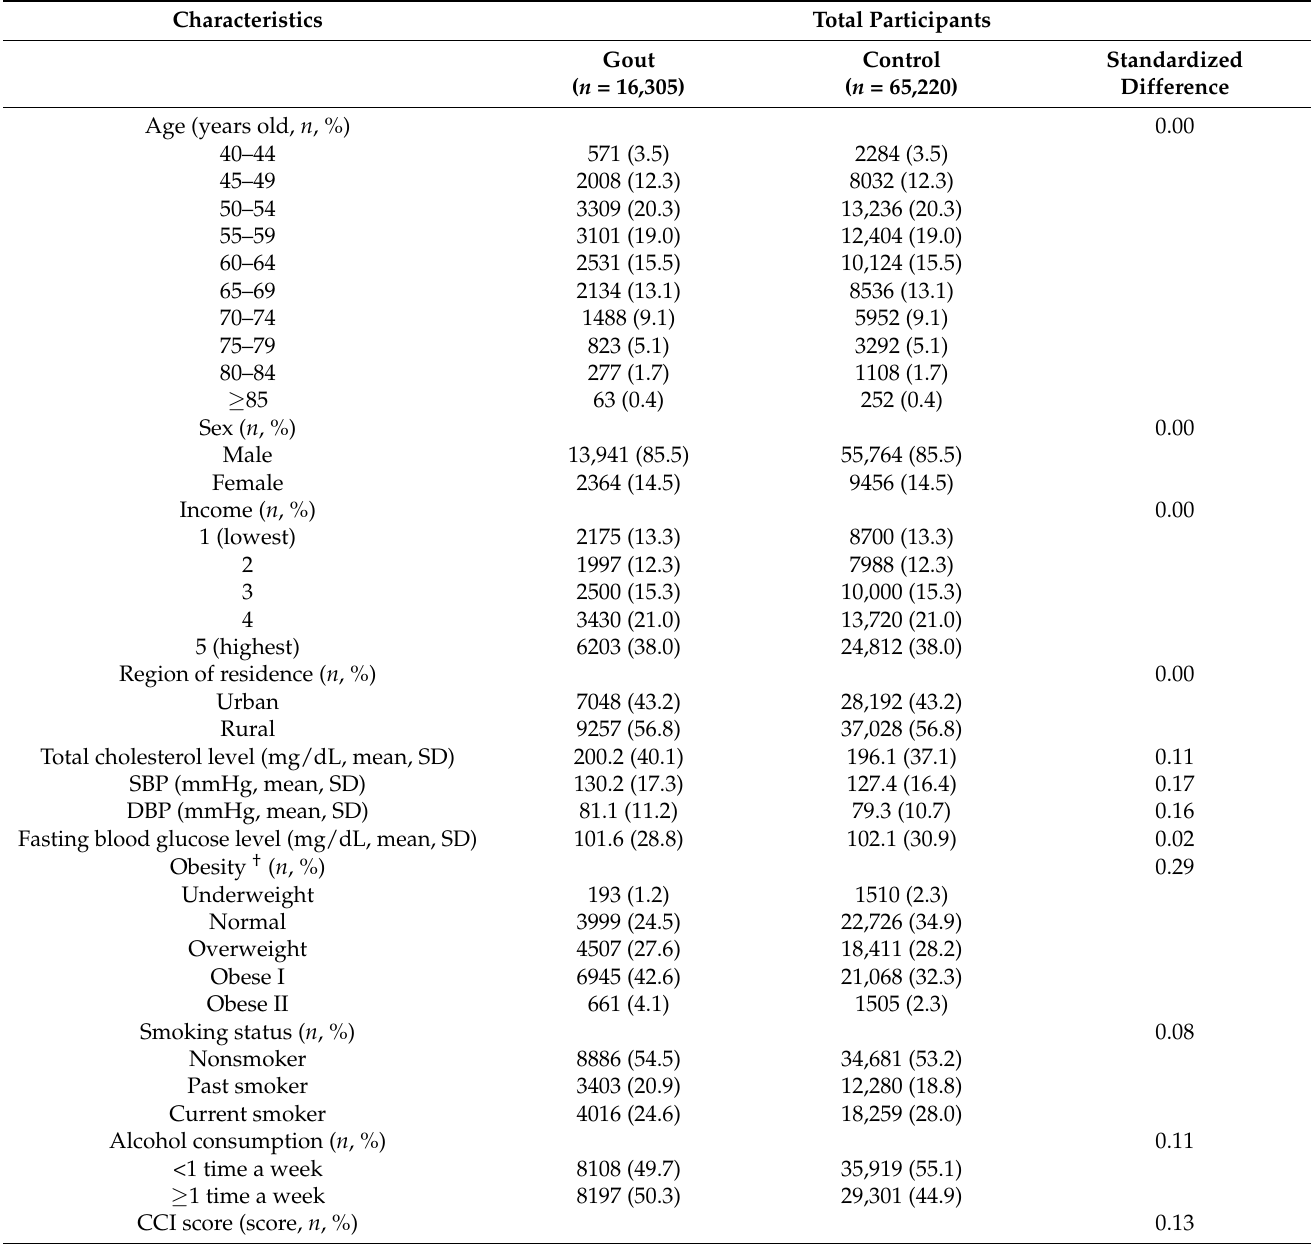
Table 1. Baseline characteristics of participants of the gout group and control